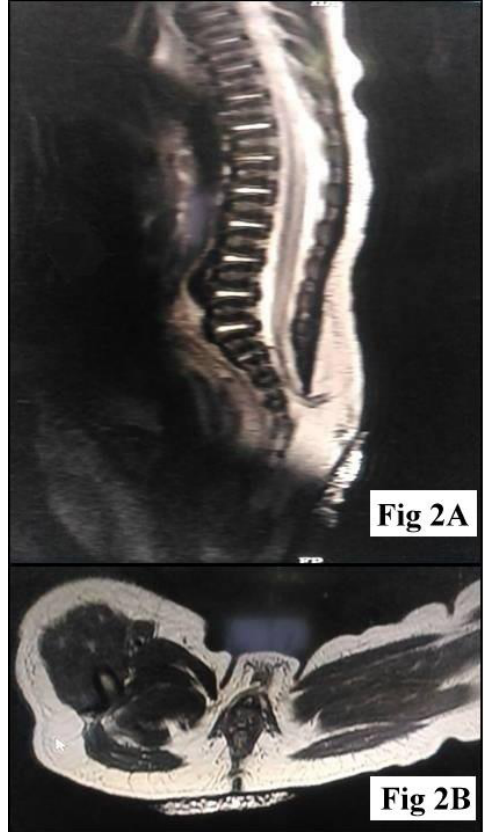
Figure 2: A (Sagital view), B (Axial view): MRI showing Spina bifida at S3, S4 and S5 levels, low lying tethered cord with conus at L5- S1 level, well defined soft tissue lesionin right lumbosacral region on external aspect of skin wth small portion attached to skin and subcutaneous tissue at S3-S4